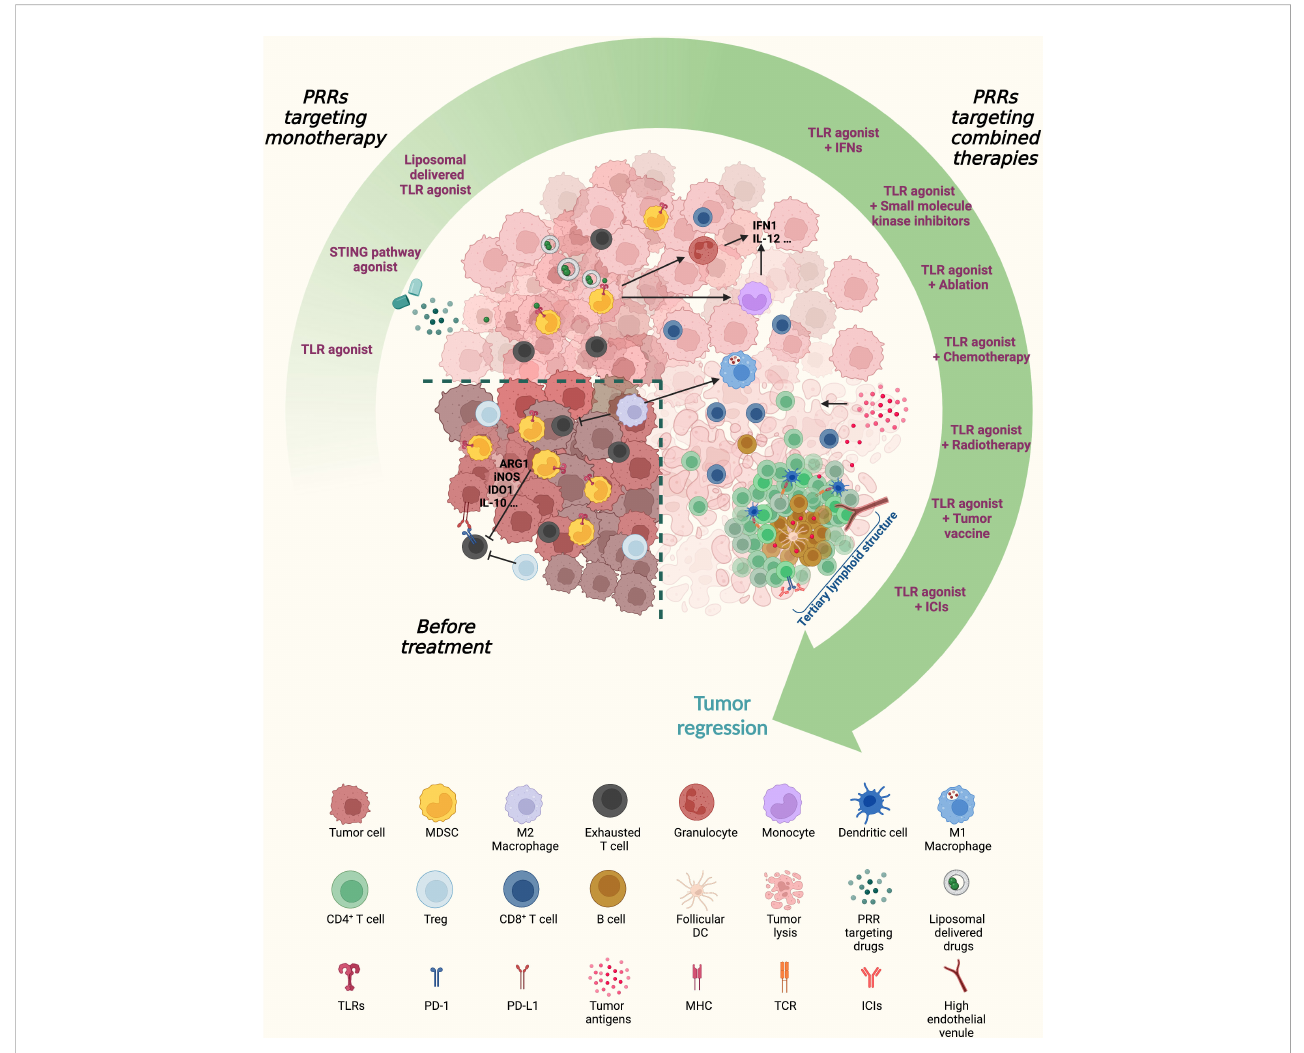
FIGURE 3 Next-generation PRR-based therapeutic approaches for cancer patients. PRR-targeting agonists, especially when combined with anti-in fl ammatory and/ or immunostimulatory agents, can switch an immunosuppressive tumor microenvironment (TME) hostile for T cell traf fi cking and fi tness toward an immunogenic milieu. PRR agonists promote MDSC maturation into in fl ammatory monocytes and granulocytes and increase the M1/M2 macrophage ratio. Combining PRR-targeting therapies with classic immunotherapy might support the establishment of TLSs containing a CD3 + T cell zone with mature dendritic cells (DCs) and a germinal center with B cells and follicular DCs. The coordinated actions of tumor antigen presentation through DCs and cytotoxic effector T cells and B cells enable the in situ priming and sustainment of antitumor adaptive immunity. MDSCs, myeloid-derived suppressor cells; DCs, dendritic cells; Treg, regulatory T cell; PRRs, pattern recognition receptors; TLR, Toll-like receptor; STING, stimulator of interferon genes; IFN, interferon; ICIs, immune checkpoint inhibitors; Arg1, arginase 1; iNOS, inducible nitric oxide synthase; IDO1, indoleamine 2,3-dioxygenase 1; PD1, programmed cell death protein 1; PD-L1, programmed death-ligand 1; TLS, tertiary lymphoid structure; MHC, major histocompatibility complex; TCR, T cell